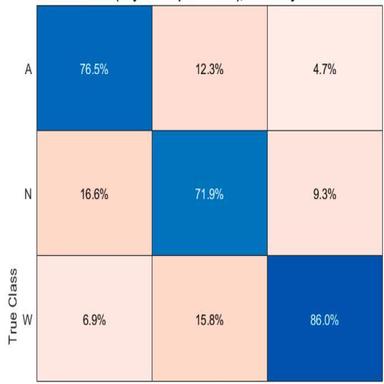
Confusion matrix for the SVM supervised machine learning algorithm, used for zone classification; accommodation (A), navigation (N), work (W) spaces, considering the entire data set. PPV represents the Positive Predictive Values, and FDR the False Discovery Rate.